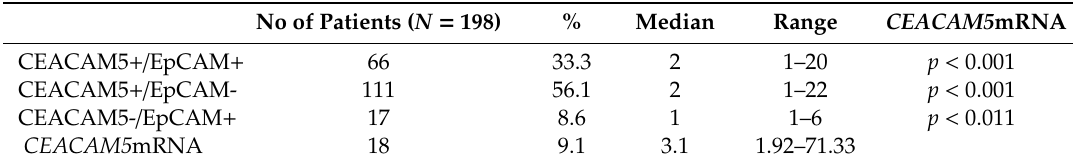
Table 2. Heterogeneity of circulating tumor cell (CTC) sub-populations and correlation with CEACAM5mRNA